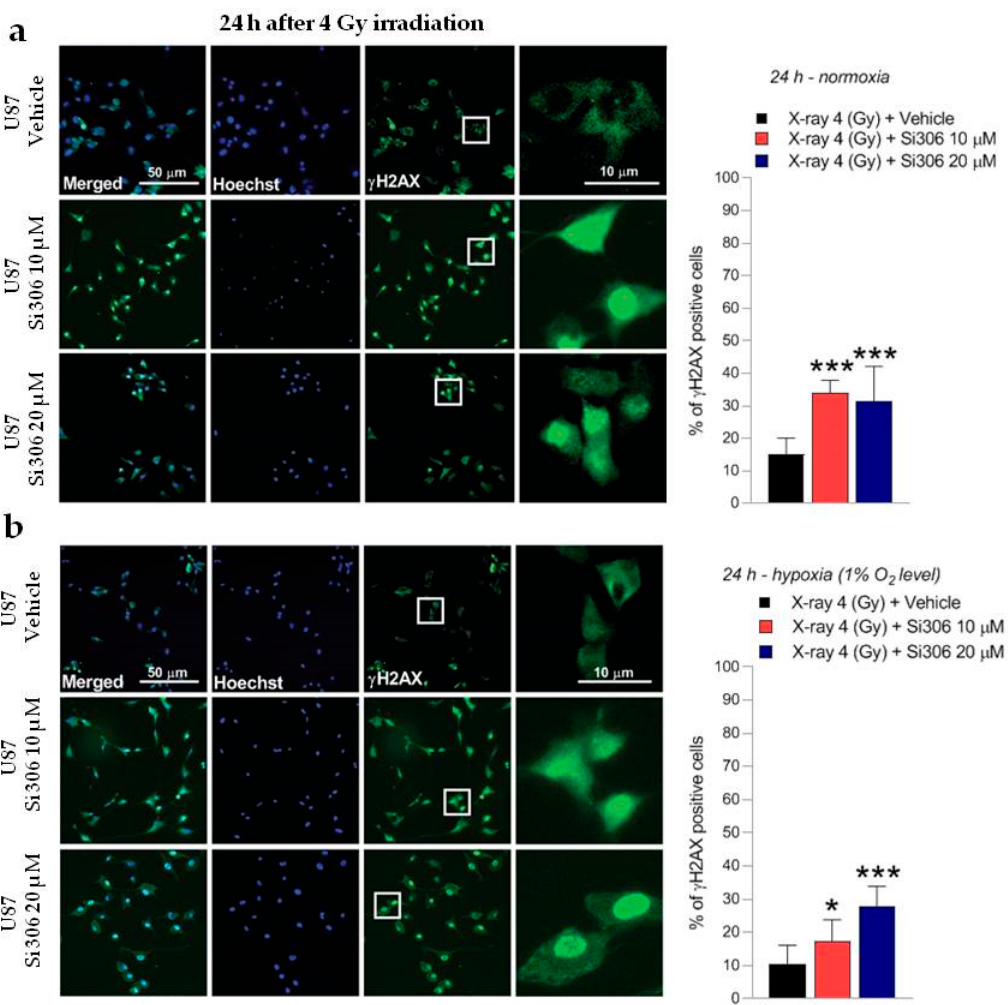
Figure 8. Representative pictures with inserts (white squares) and quantification of U87 positive cells for γ H2AX realized 24 h after 4 Gy irradiation in normoxia ( a ) and hypoxia ( b ). Data are mean ± SD of n = 3 independent experiments; * p -value < 0.05 and *** p -value < 0.001 versus 4 Gy + vehicle (F normoxia = 16.82, p -value < 0.0001; F hypoxia = 12.77, p -value = 0.0004. One-way ANOVA with Holm–Šídák post-hoc test).